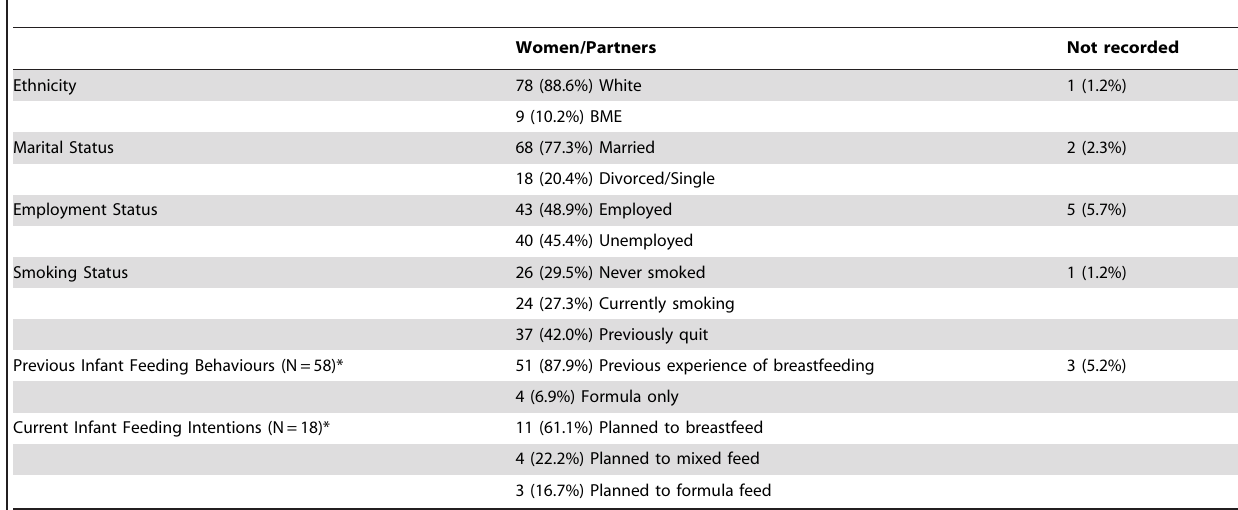
Table 4. Summary of characteristics of women and partner